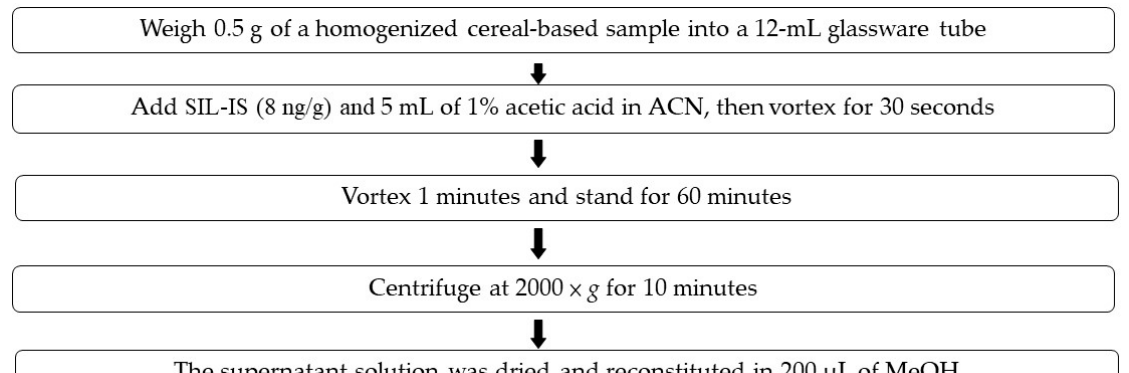
Figure 2. A flowchart of sample pretreatment, solid–liquid extraction.